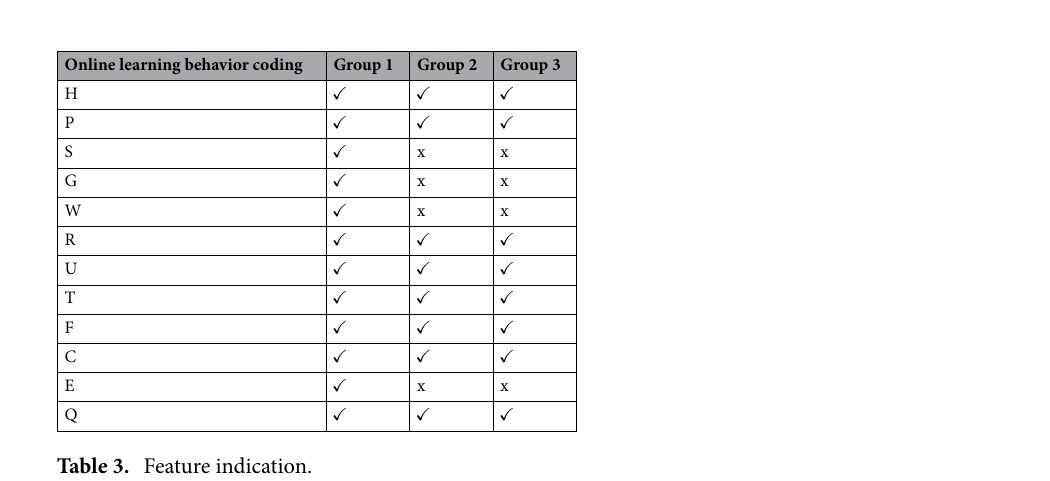
Table 2. E-learning behavior and coding of DDD courses.